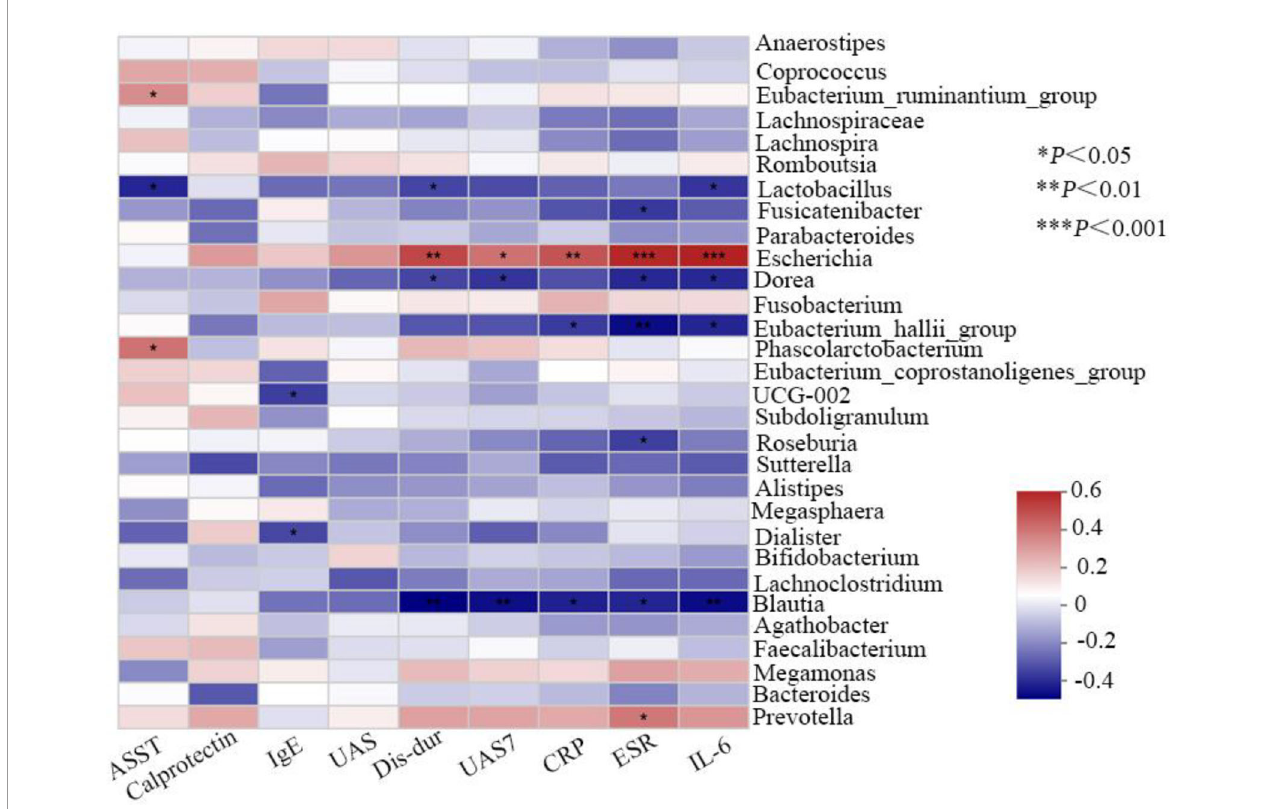
FIGURE 5 | Correlation analysis of gut bacteria and related clinical